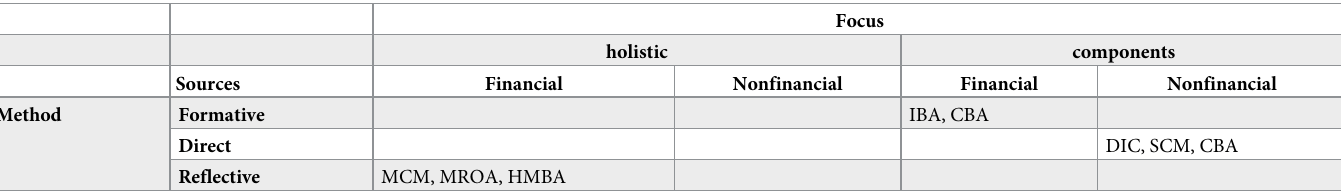
Table 1. Classification of measurement